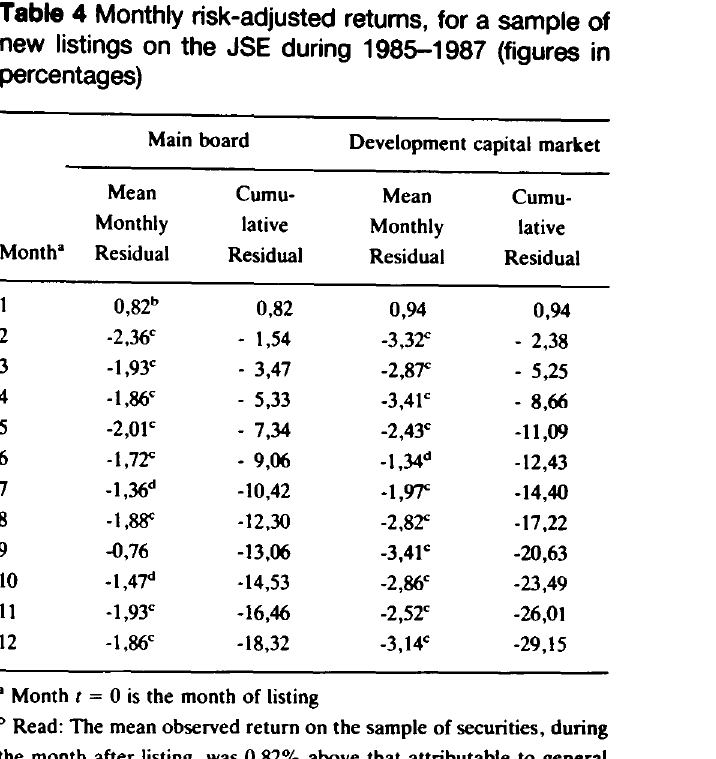
Table. 4. Monthly risk-adjusted returns, for a sample of new listings on the JSE during 1985-1987 (figures in percentages) Main